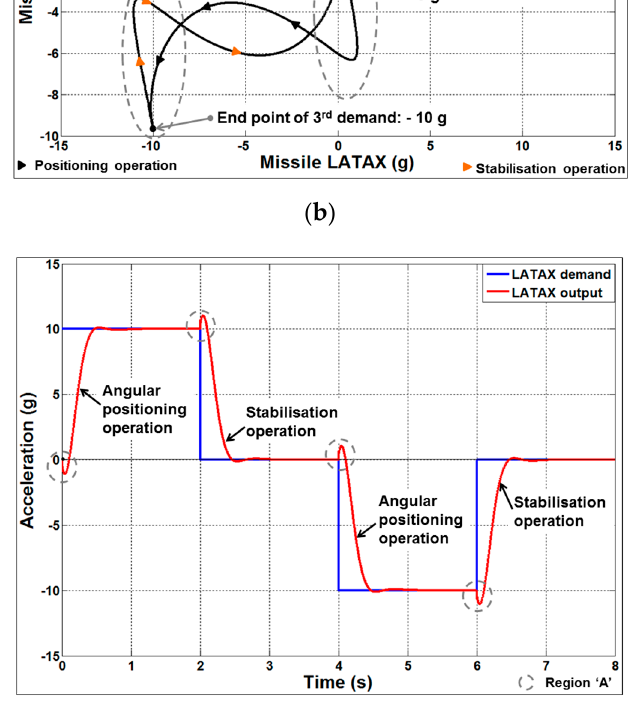
Figure 12. Cont. Figure 12.